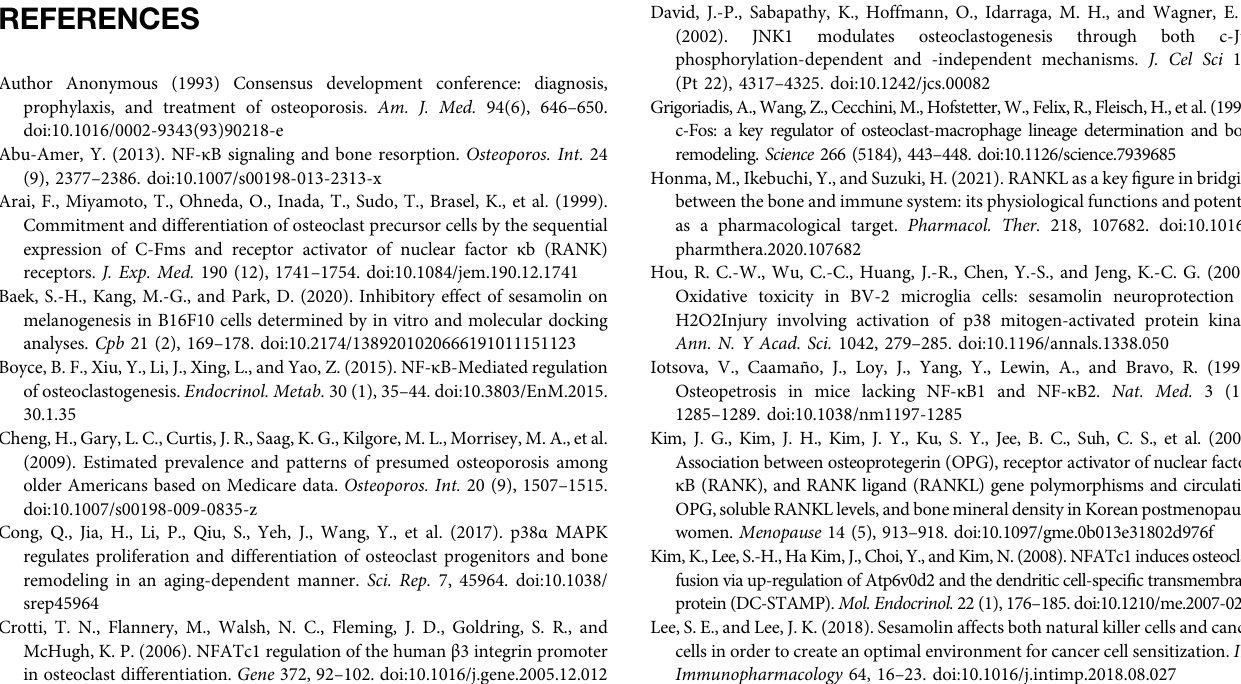
Figure S1 | Ses inhibits the expression of osteoclast-speci fi c genes in vivo. (A-B) Theexpressionlevelsoftheosteoclast-relatedspeci fi cgenesCtskandMmp-9were analyzed by qPCR. The above data are expressed as the mean ± SD; *p < 0.05 and ***p < 0.001. Ses, sesamolin; Vehicle, 1% DMSO in PBS; E2, estogen; Ctsk, cathepsin K, Mmp-9, matrix metalloproteinase-9. Figure S2 | Ses inhibits the expression of Ctsk in ovariectomized mice, but has no effect on the expression of OCN. (A) The representative images of Ctsk and OCN immunohistochemical staining in mice in each group. (B) Quantitative analysis of the numberofCtsk-positiveosteoclastsineachgroup(n (cid:1) 3).(C)Quantitativeanalysisof OCN positive area ineach group (n (cid:1) 3). The above data are expressed as themean ± ; **p < 0.01. Ses, sesamolin; Vehicle, 1% DMSO in PBS; E2, estrogen; Ctsk, cathepsin K, OCN, osteocalcin. Figure S3 | The original Western Blot images of p-p65, p65, I κ B- α , β -actin, p-ERK, ERK, p-JNK, JNK, p-p38and p38. Figure S4 | The original Western Blot images of NFATc1, c-Fos and β